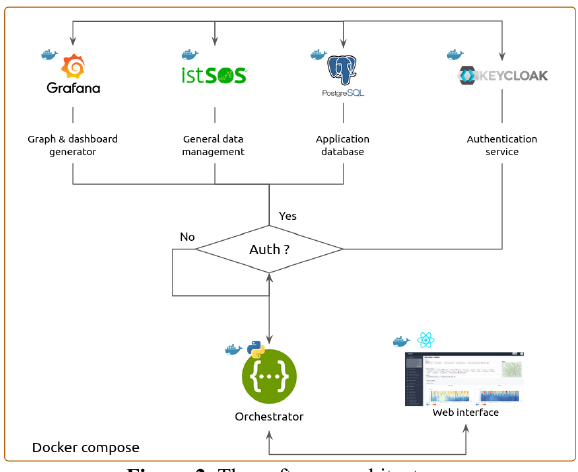
Figure 2 . The software architecture.